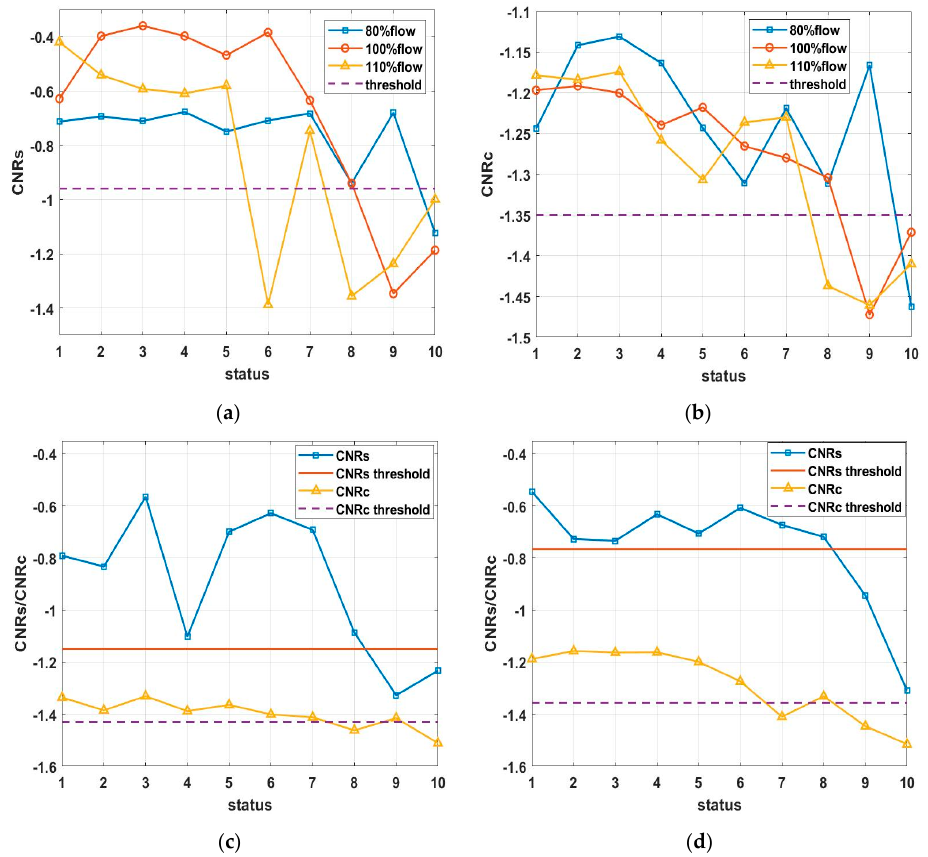
Figure 15 . Feature parameters (CNRs and CNRc) against Constant False Alarm Rate (CFAR) thresholds at 80%, 100%, and 110% flow rates, with data obtained from Sensor 15, 17, and 19. False alarm rate remains at 5%. Detection rate of incipient cavitation is more than 90%. ( a ) CNRs curves and CFAR threshold along with 10 statuses at different flow rates, obtained from data at Sensor 15 ; ( b ) CNRc curves and CFAR threshold along with 10 statuses at different flow rates, obtained from data at Sensor 15 ; ( c ) CNRs curves, CNRc curves, and their CFAR thresholds, at a 100% flow rate, obtained from data at Sensor 17 ; ( d ) CNRs curves, CNRc curves, and their CFAR thresholds, at a 100% flow rate, obtained from data at Sensor 19 . Note that the vertical labels denote the amplitude.